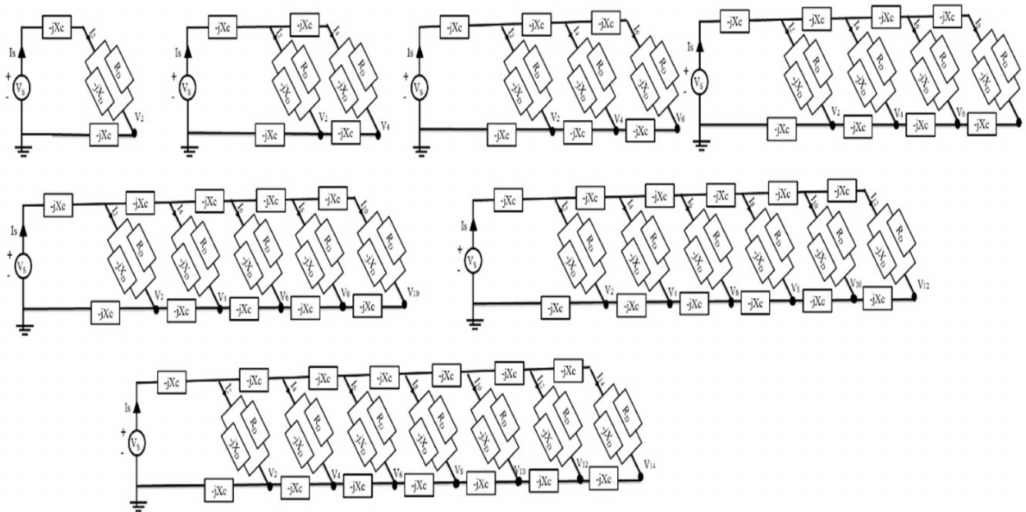
Figure 8. The linearized design of Cockcroft–Walton during positive peak.